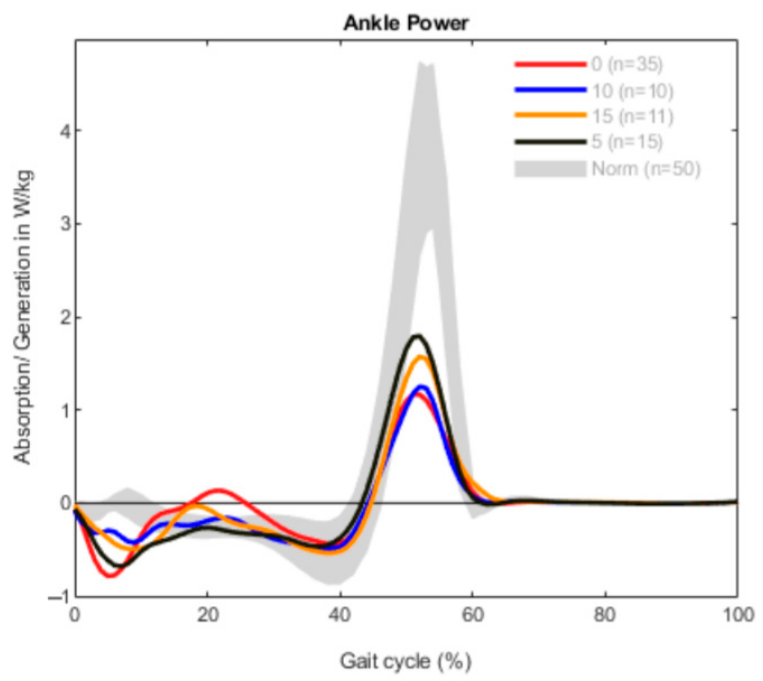
Figure 6. Ankle power measurement in the unilateral group ( n = 71).